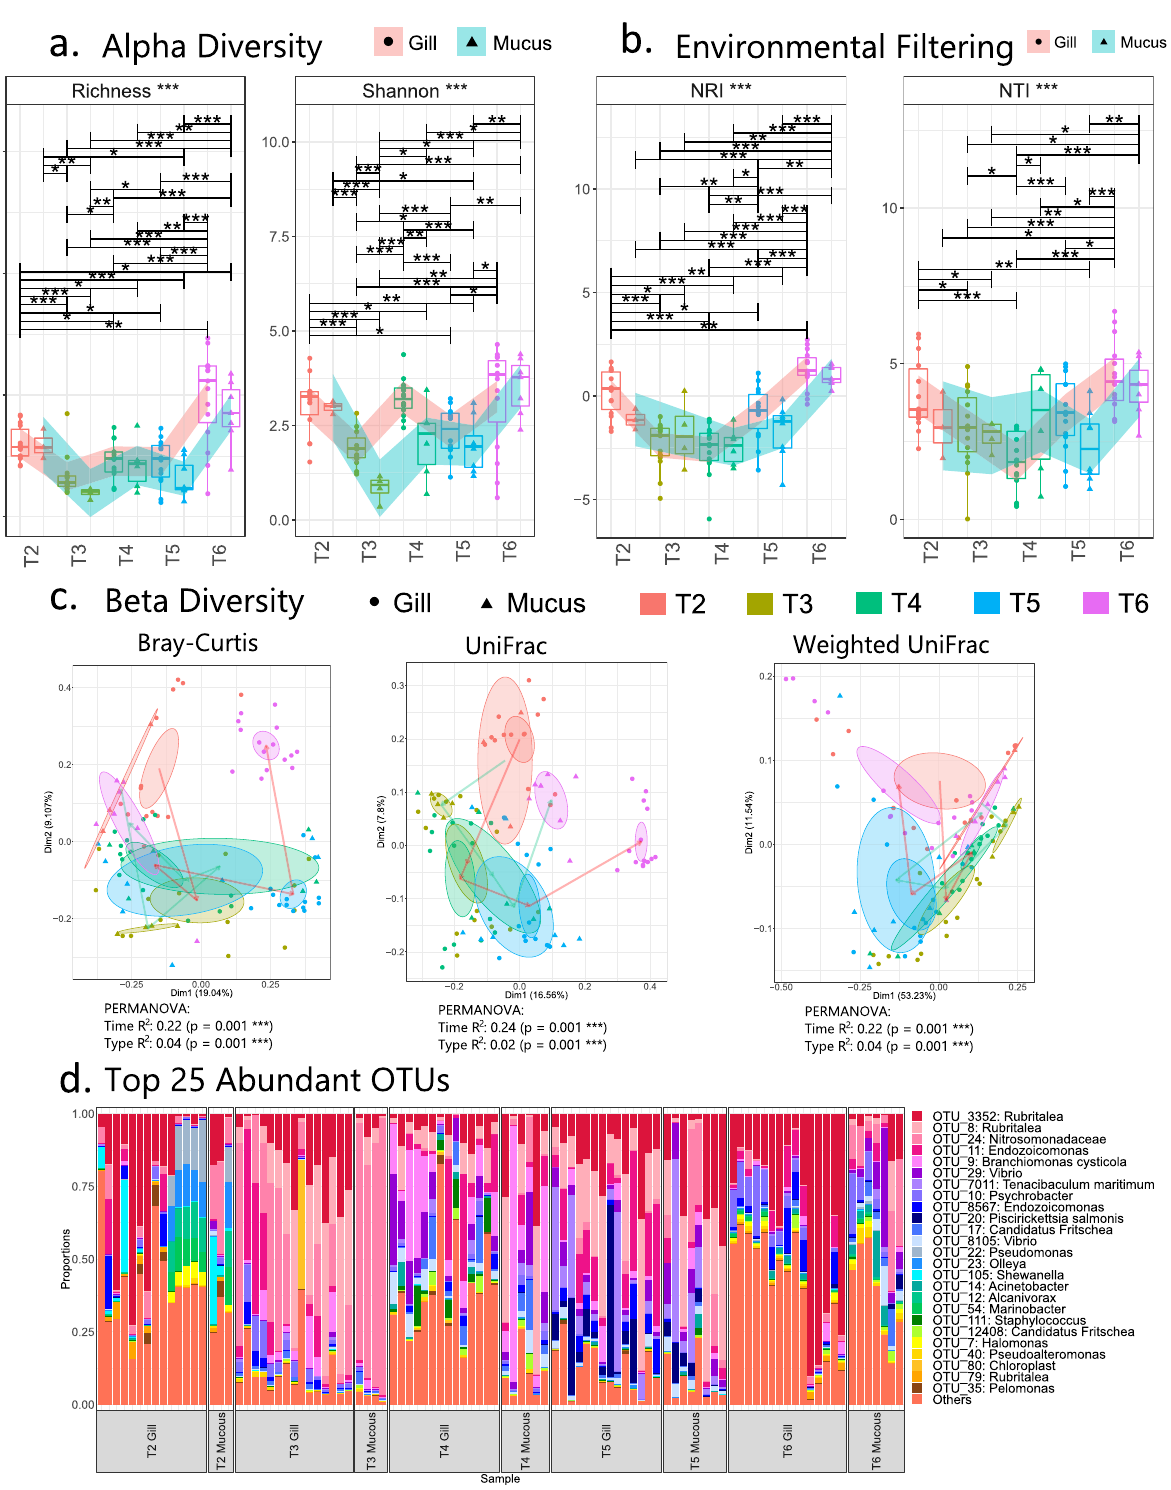
Figure 5. Microbial diversity and community structure from for cross-sectional ‘gill vs mucus’ analyses. ( a – c ) represent alpha diversity, environmental filtering, and beta diversity indices, respectively. In ( a ) and ( b ), that LOESS smoothing was performed separately on gill and mucus samples, and PERMANOVA now considers both Time and Type parameters. In ( c ), ellipses are drawn at 95% confidence interval of standard error with lines from T2 to T6 plotted at the mean of the ordination values. ( d ) Shows community structure based on relative abundance of the top25 most abundant OTUs; lines for figures ( a ) and ( b ) connect two categories where the differences were significant (ANOVA) with *( P < 0.05), **( P < 0.01), or ***( P < 0.001). Figure titles with *** refer to analyses that included significant